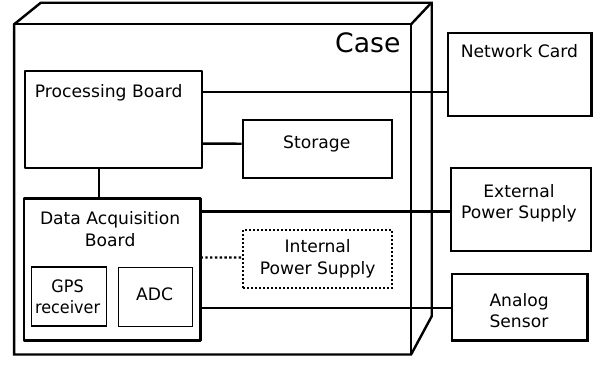
Figure 2. Node hardware architecture – components represented by Fig. 2: Node hardware architecture — components repre- dotted lines are sented in dotted lines are optional or kernel space. Kernel space is strictly reserved for running